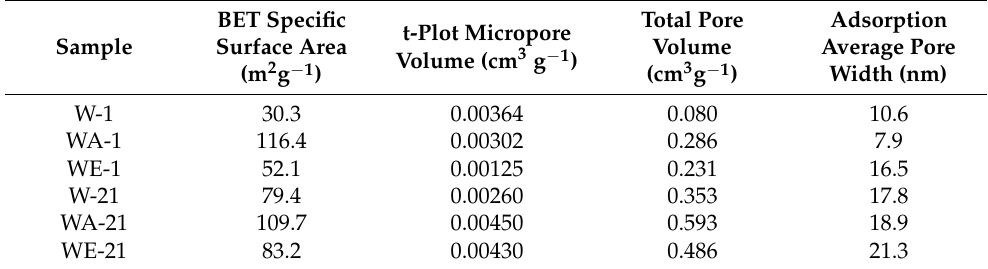
Table 3. The textural parameters of the powder